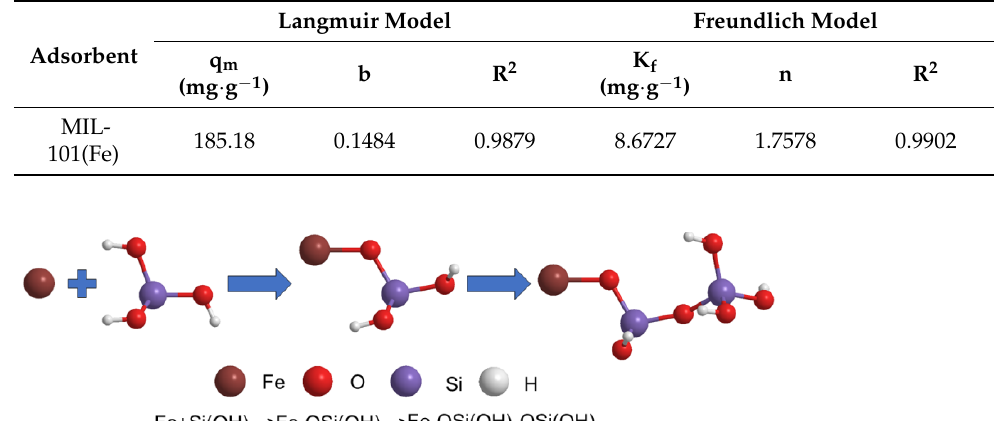
Table 2. Isotherm parameters of silicic acid adsorption process.